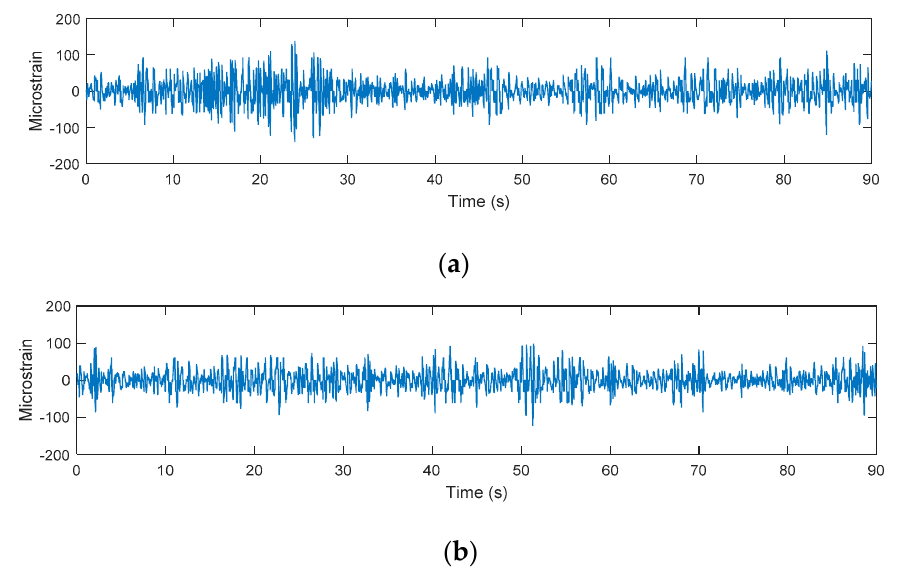
Figure 8. Elastic-energy model strain signals: ( a ) Highway A, ( b ) Highway B.